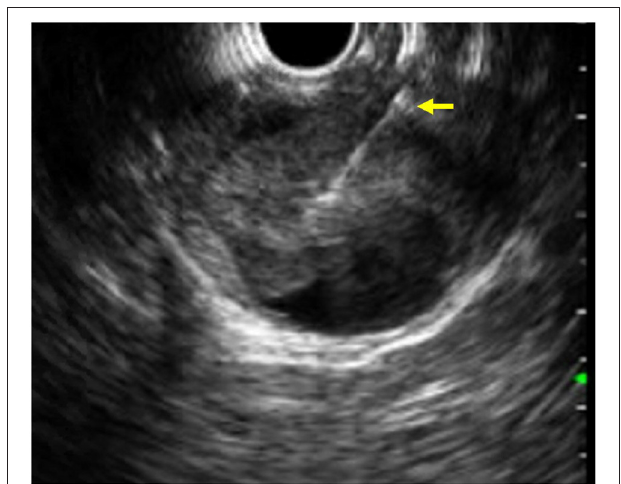
FIGURE 1 | EUS image of a fine needle biopsy (yellow arrow) performed on a solid pseudopapillary tumor of the